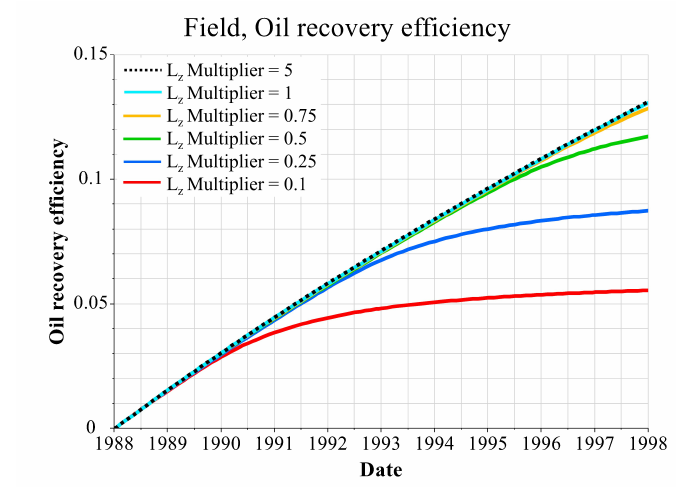
Figure 8. Matrix block height sensitivity by using property multipliers to maintain the variation in the originally characterized values for each layer in the model. The evaluation was implemented using the Quandalle and Sabathier formula [17].